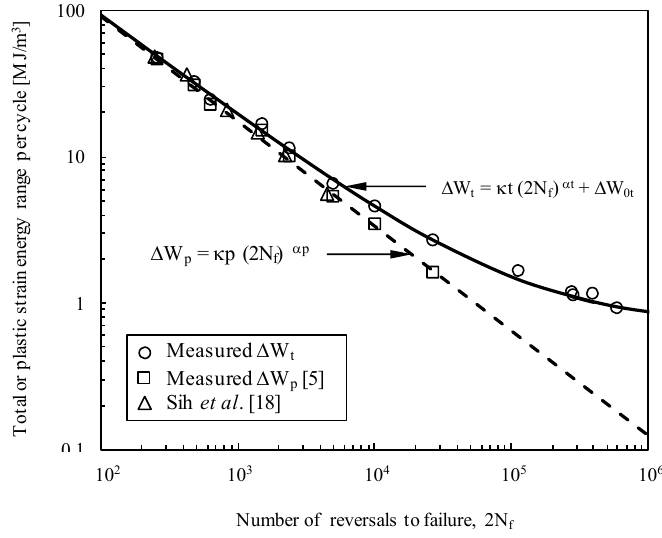
Figure 12. Total and plastic strain energy dissipated per cycle versus number of reversals to failure. Table 3. Constants of Equations (9) and (11).